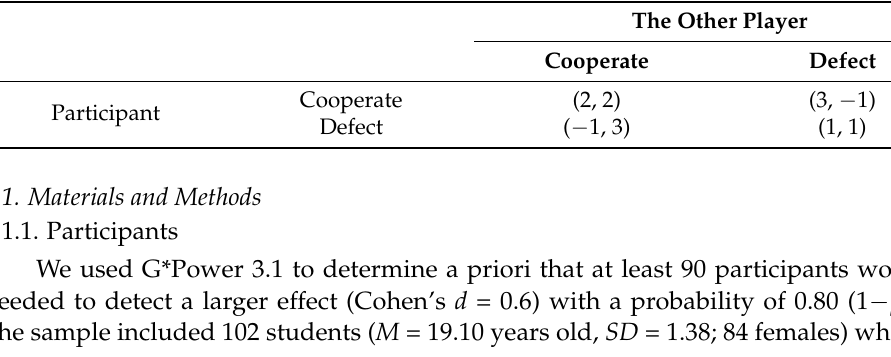
Table 1. The payoff matrix of the